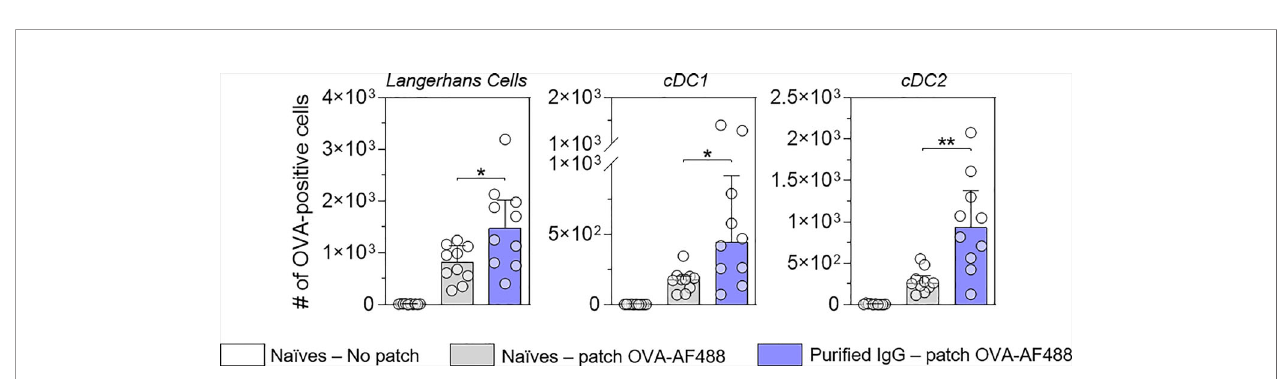
FIGURE 4 | IgG increases the number of allergen-positive DC in local lymph nodes. Mice received puri fi ed IgG (in blue) obtained from OVA-sensitized mice. As negative control, mice were kept untreated (in grey). The next day, recipient mice received a patch containing OVA-AF-488 on depilated areas of the back or remained untreated as a negative control (in white). Forty-eight hours after patch application, brachial draining lymph nodes were collected, and cells were analyzed by fl ow cytometry. The number of OVA positive cells was measured among migratory Langerhans cells, cDC1 and cDC2, as indicated (N = 10 per group, single experiment). Data are median and interquartile ranges of individual values. P values were determined using the Mann-Whitney test (*P < 0.05; **P < 0.01; n.s., non-signi fi